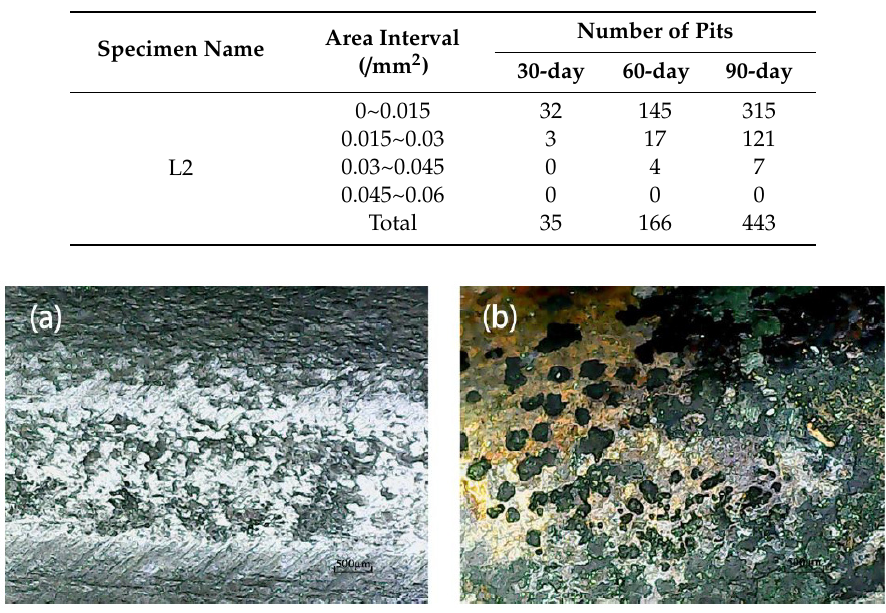
Figure 4. Contrast before and after corrosion; ( a ) steel surface before corrosion, ( b ) steel surface after corrosion.